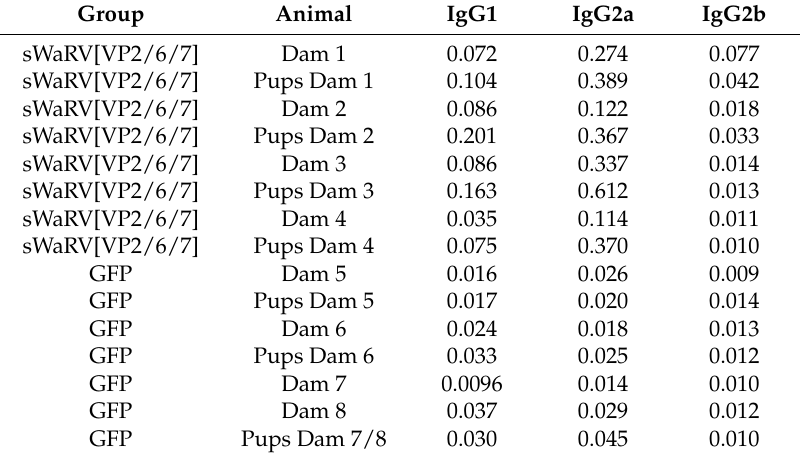
Table A4. Optical density values of IgG isotype ELISA from serum samples (diluted 1:1000) of sWaRV[VP2/6/7] or GFP control immunized animals. Group